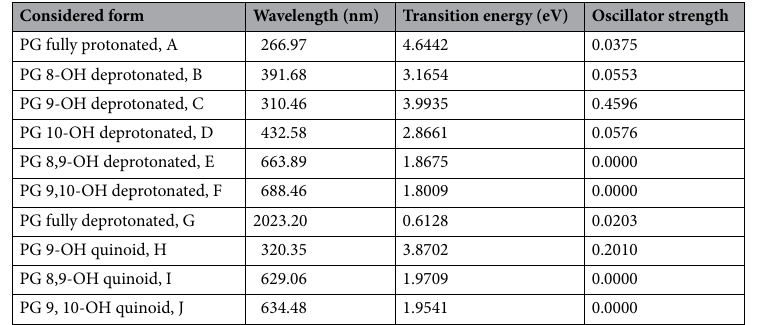
Table 1. Lowest energy transition wavelength and oscillator strength calculated for the different protonation states of propyl gallate and quinoid propyl gallate. Notes: Structures are indicated in Fig. 1 F-O. All the structures were calculated using the exact same parameters with the time-dependent density functional theory level (TD-DFT) method and solvent water. PG-propyl